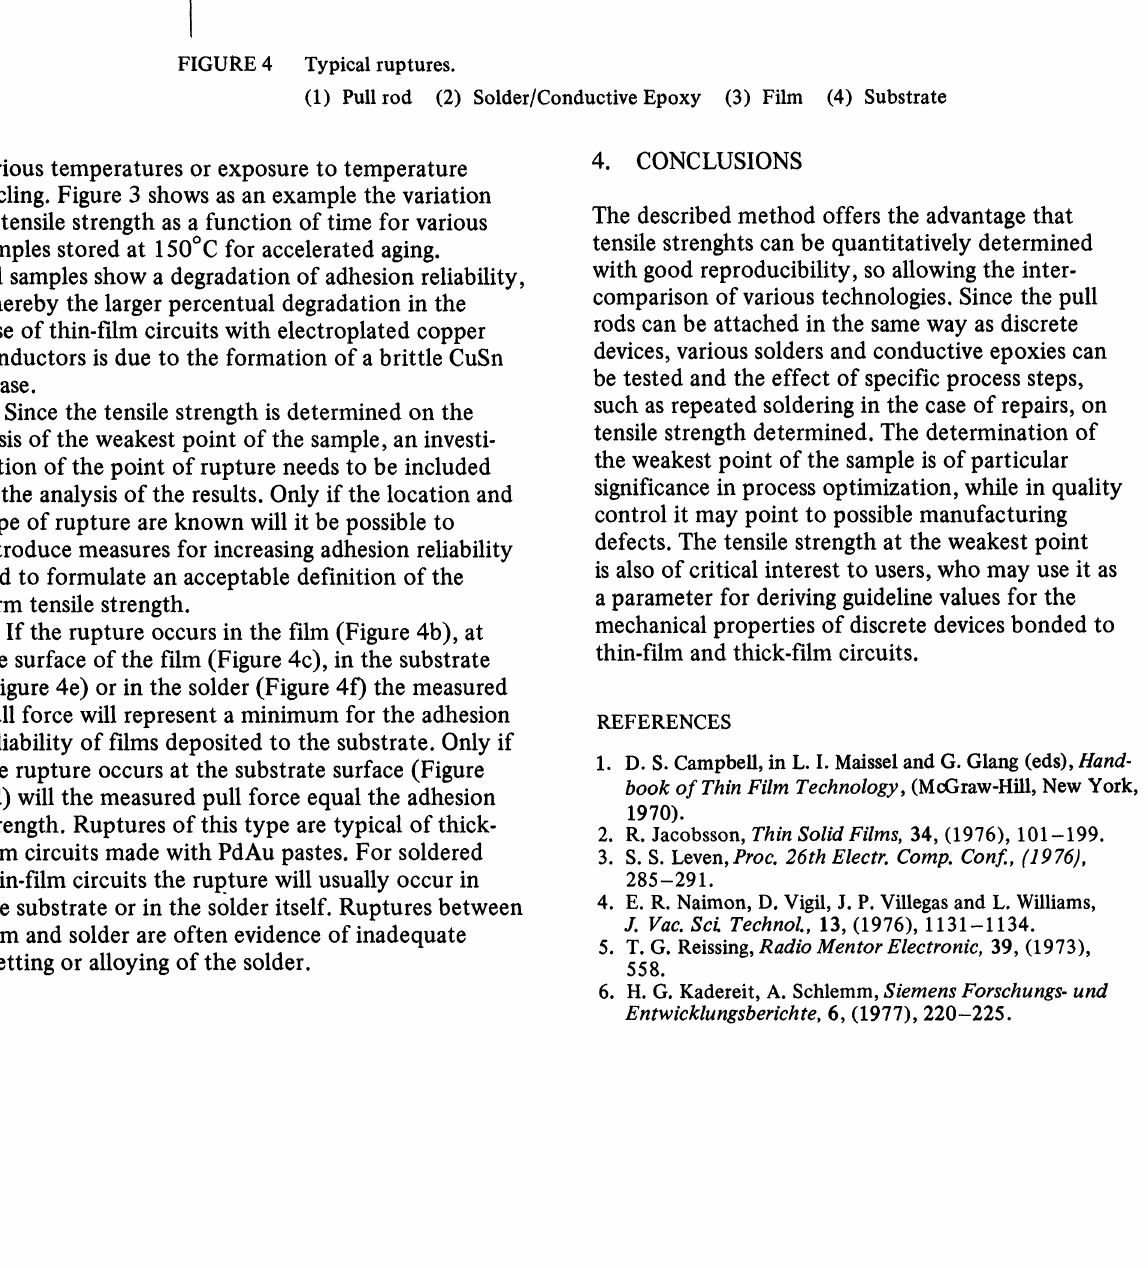
FIGURE 4 Typical ruptures. (1) Pull rod (2) Solder/ConductiveEpoxy (3) Film (4)